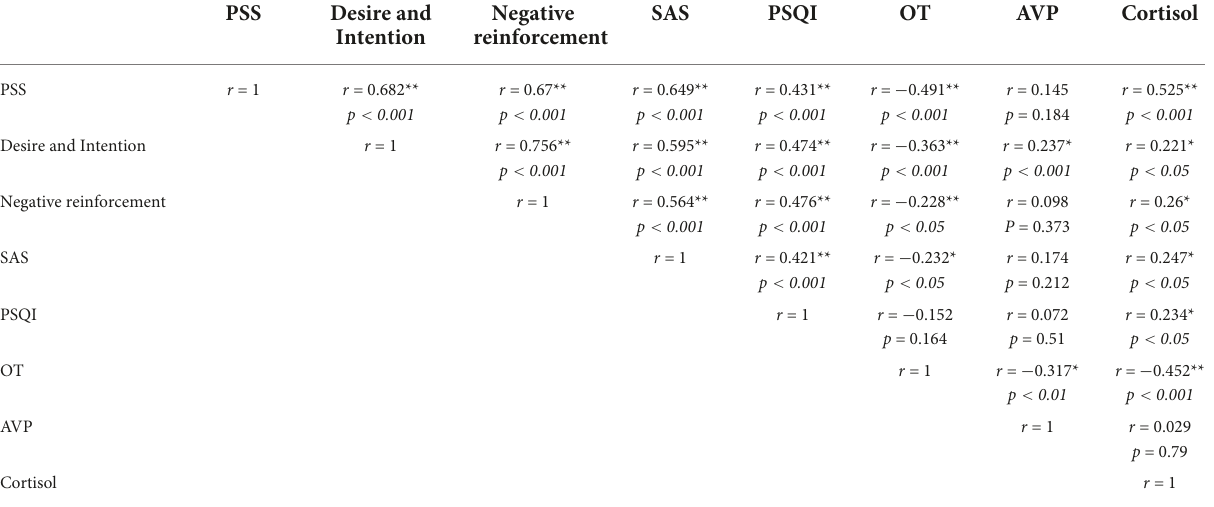
TABLE 2 Correlation analysis results of various dimensions between psychological scale and blood